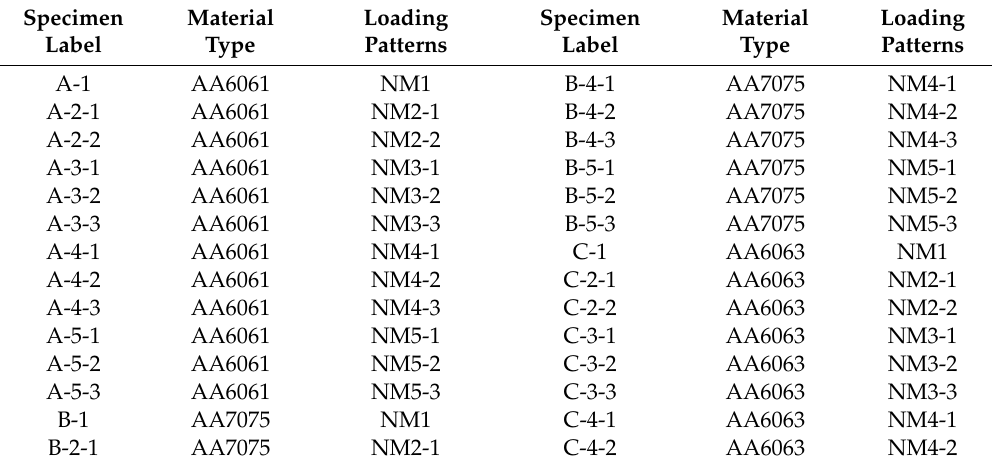
Systems (China) Co., Ltd., Shenzhen, China). The gauge length of the extensometer was 50 mm, and the original gauge length L 0 was 50 mm; the tension and pressure ranges of the extensometer were both 25%. A total of 12 loading patterns were used in the test, and the loading process was process controlled by the displacement; the test loading speed was 0.8 mm / min. The loading scheme is shown in Figure